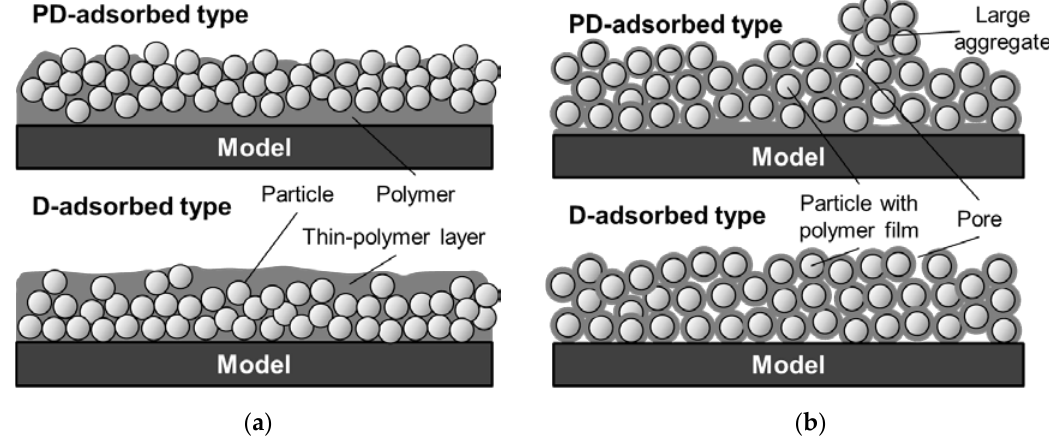
Figure 16. Modified sketches of structures of PC-PSP with toluene solvent ( a ) when the particle content is less than the CPVC and ( b ) when the particle content exceeds the CPVC.